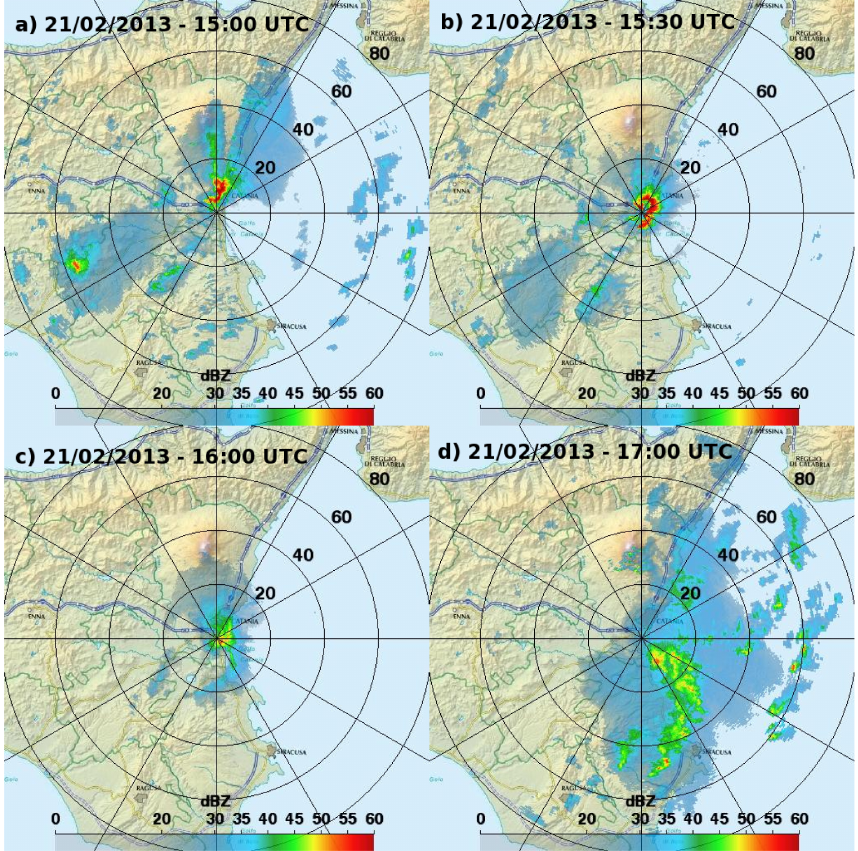
Figure 5. Vertical maximum intensity maps as retrieved on 21 February 2013 at 15:00, 15:30, 16:00 and